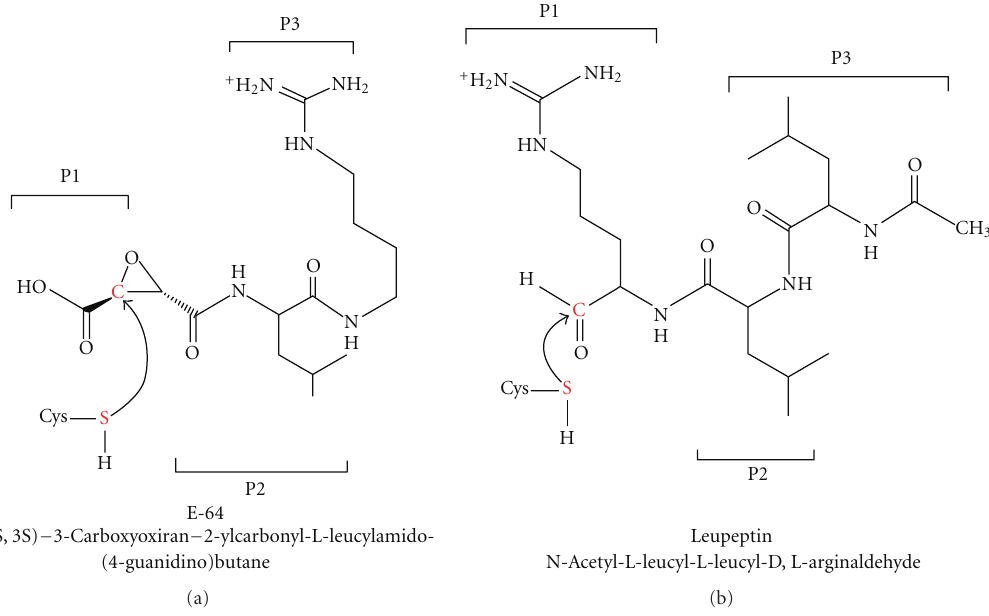
Figure 8: Chemical structures of E-64 and leupeptin. The positions of P1, P2, P3 of the inhibitors that occupy the S1, S2, and S3 subsites of enzyme, respectively, are labeled. Inhibitor and enzyme groups which are involved in covalent bond formation are shown in red.